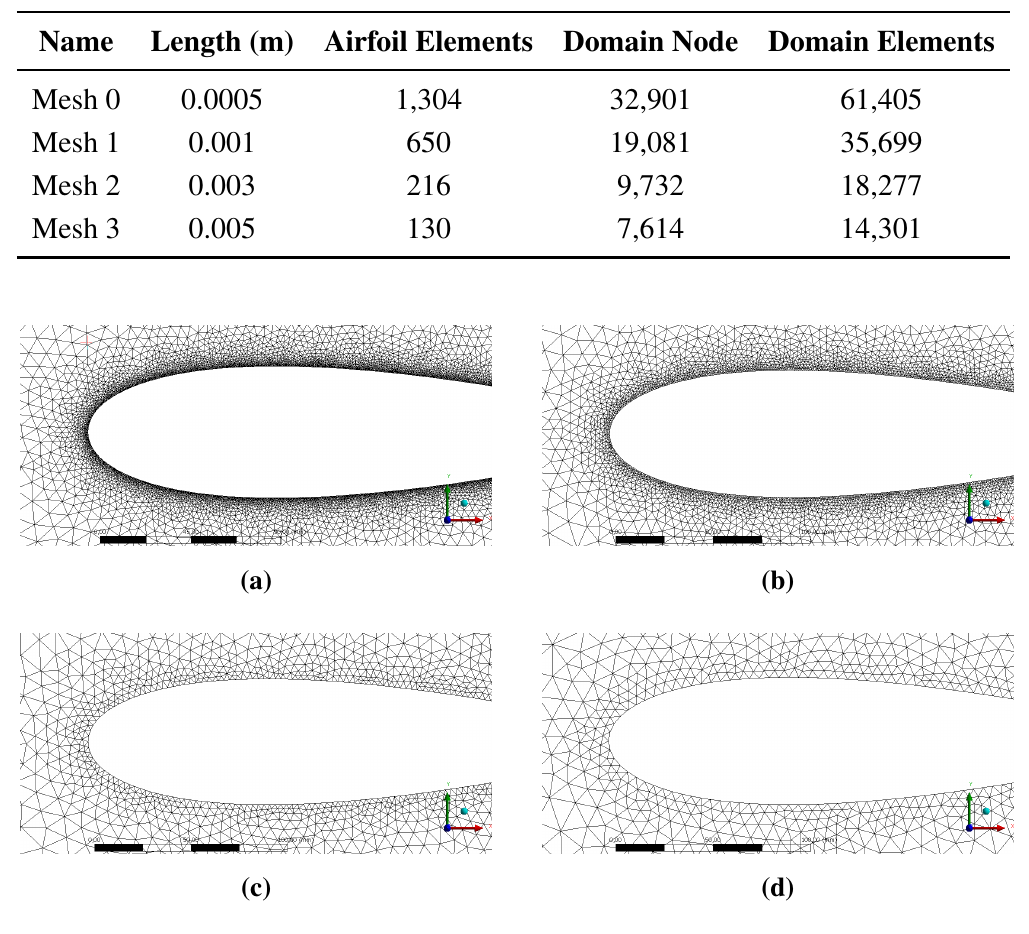
Figure 2. Mesh discretization along the two-dimensional turbine blade airfoils. ( a ) Mesh 0; ( b ) Mesh 1; ( c ) Mesh 2; ( d ) Mesh